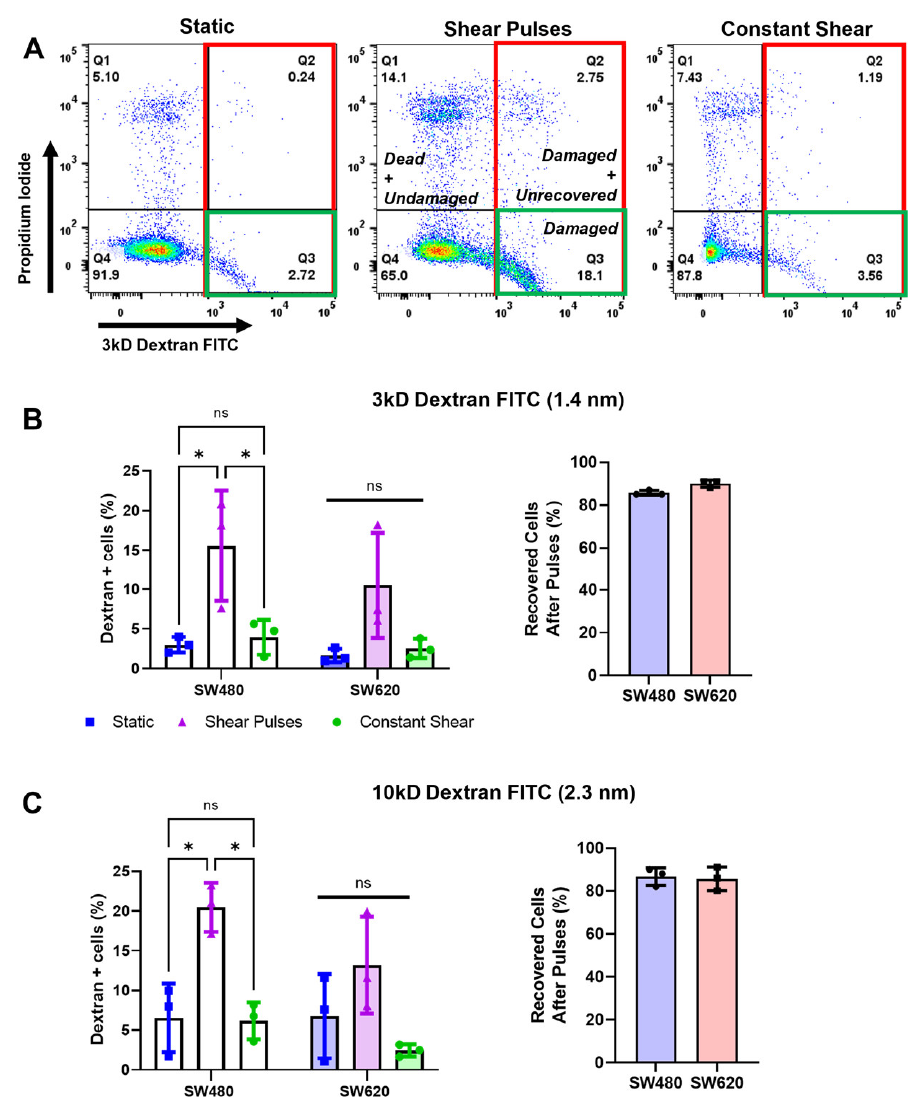
Figure 4. Shear pulses cause cell-membrane damage, indicated by membrane-pore formation, which is rapidly repaired. ( A ) Representative flow plots demonstrating enhanced dextran internalization after pulses of FSS. The percentages of damaged cells are shown in red and green (dextran+, Q3 and Q2), while the percentages of damaged cells that were unrecovered are shown in green (dextran+ and PI+, Q2 only). ( B , C ) Quantification of cell-membrane damage and repair for 3kD and 10kD MW dextran, respectively. Percentage of recovered cells was calculated by dividing the population of damaged and recovered cells (Dextran+/PI+, Q3) by the total number of damaged cells (Dextran+, Q2 + Q3). N = 3, ns = not significant, * p < 0.05 (two-way ANOVA with multiple comparisons). Error bars represent mean ± SD.